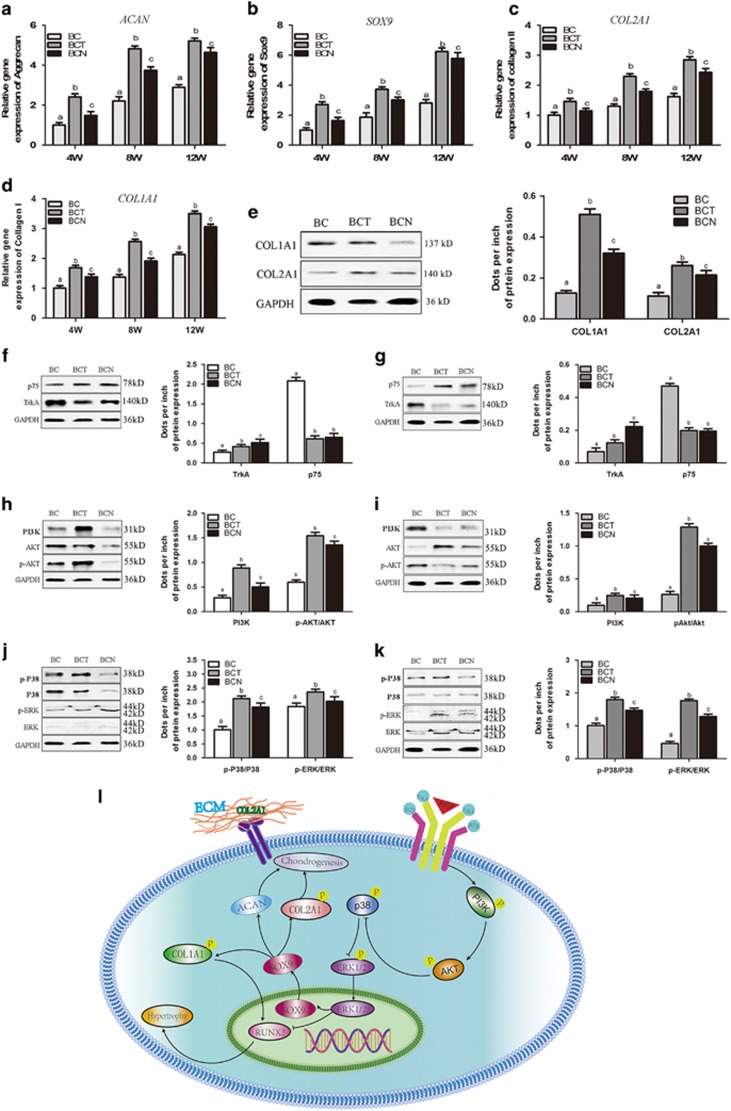
The receptors and signaling pathways that are activated in NGF-induced BMSCs in vitro and in vivo. (a-d) qRT-PCR was to determine the expression levels of the ACAN, SOX9, COL2A1 and COL1A1 genes in the repaired model after 4, 8 and 12 weeks. (e) Western blots was used to analyze the protein expression levels of Col1A1 and COL2A1. (f and g) Western blots was used to analyze the protein expression levels of the NGF receptors TrkA and p75 in vitro (f) and in vivo (g). (h and i) Western blots was used to analyze the protein expression of proteins in the PI3K/AKT signaling pathway, including PI3K, AKT and p-AKT, in vitro (h) and in vivo (i). (j and k) Western blots was used to analyze the expression of proteins in the ERK/MAPK signaling pathway, including ERK, p-ERK, P38 and p-P38, in vitro (j) and in vivo (k). (l) Schematic description of the relevant signaling pathways that were activated by NGF. The values are means±S.D., n=10 joints; bars with different letters are significantly different from each other at P<0.05